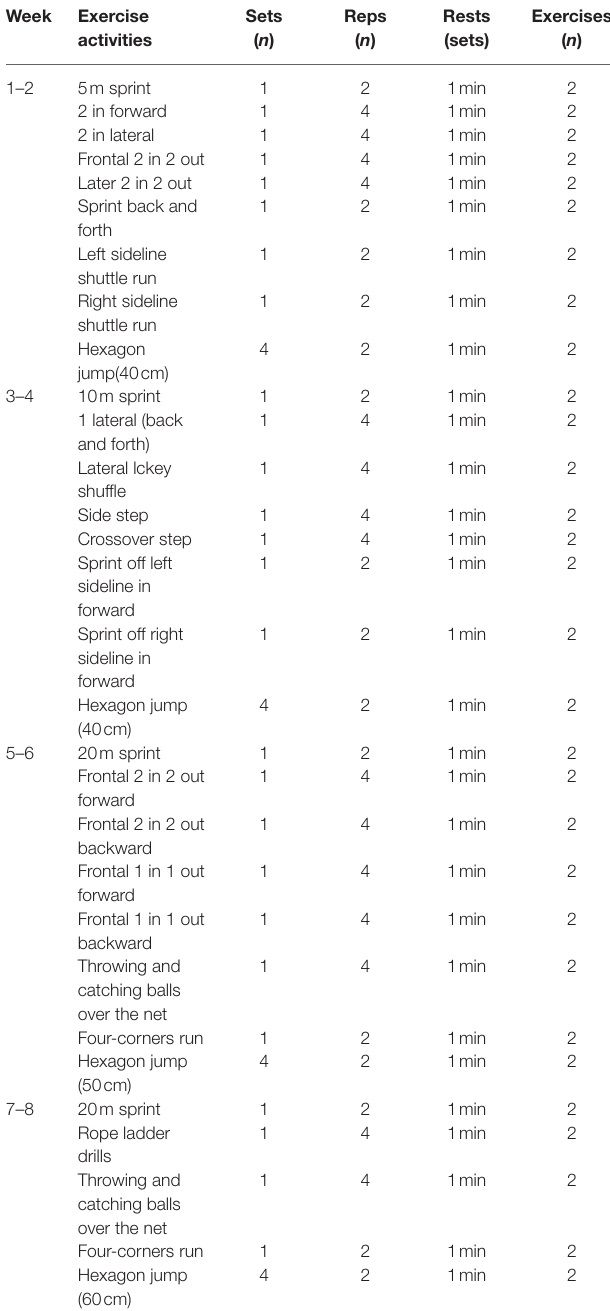
TABLE 2 | Eight-week neuromuscular training